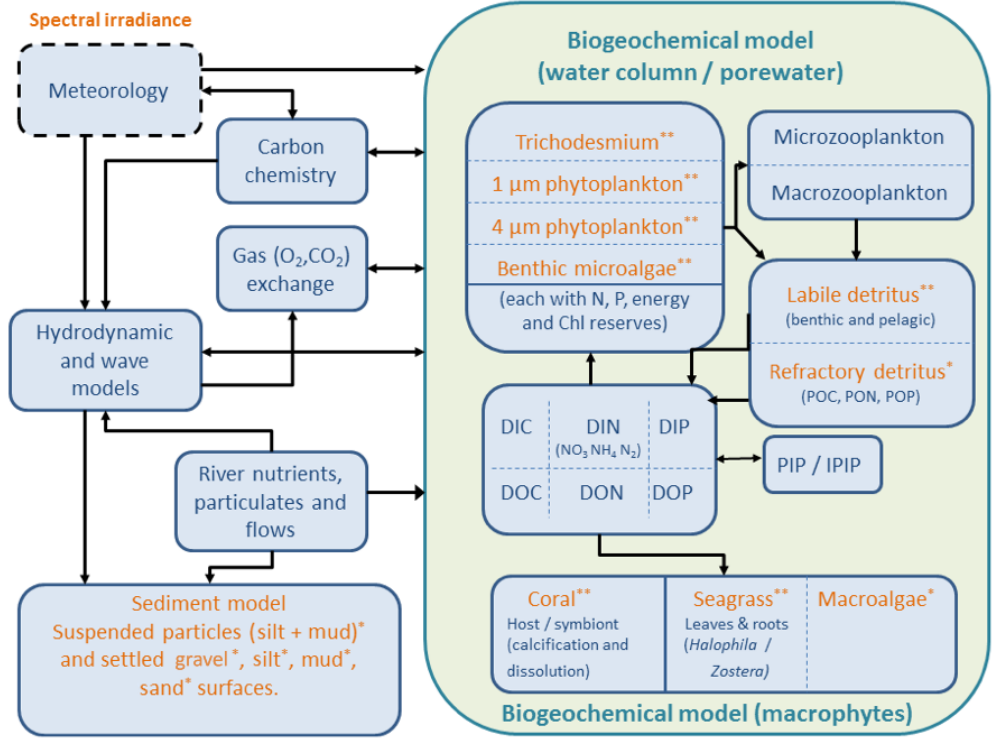
Figure 3. The eReefs modelling system with optically active components identified with beige colouring and an asterisk, with the number of asterisks denoting the number of different optically active elements with this component. Thus, each of the four microalgae have two pigment types, one absorbing like divinyl chlorophyll a , and the other like photosynthetic carotenoids. There are two seagrass types, and corals have both skeletons and zooxanthellae. There are three types of detritus that absorb and scatter, and the sediment model contains a suspended fraction and four (mixed) sediment compositions. Additionally, pure seawater both absorbs and scatters